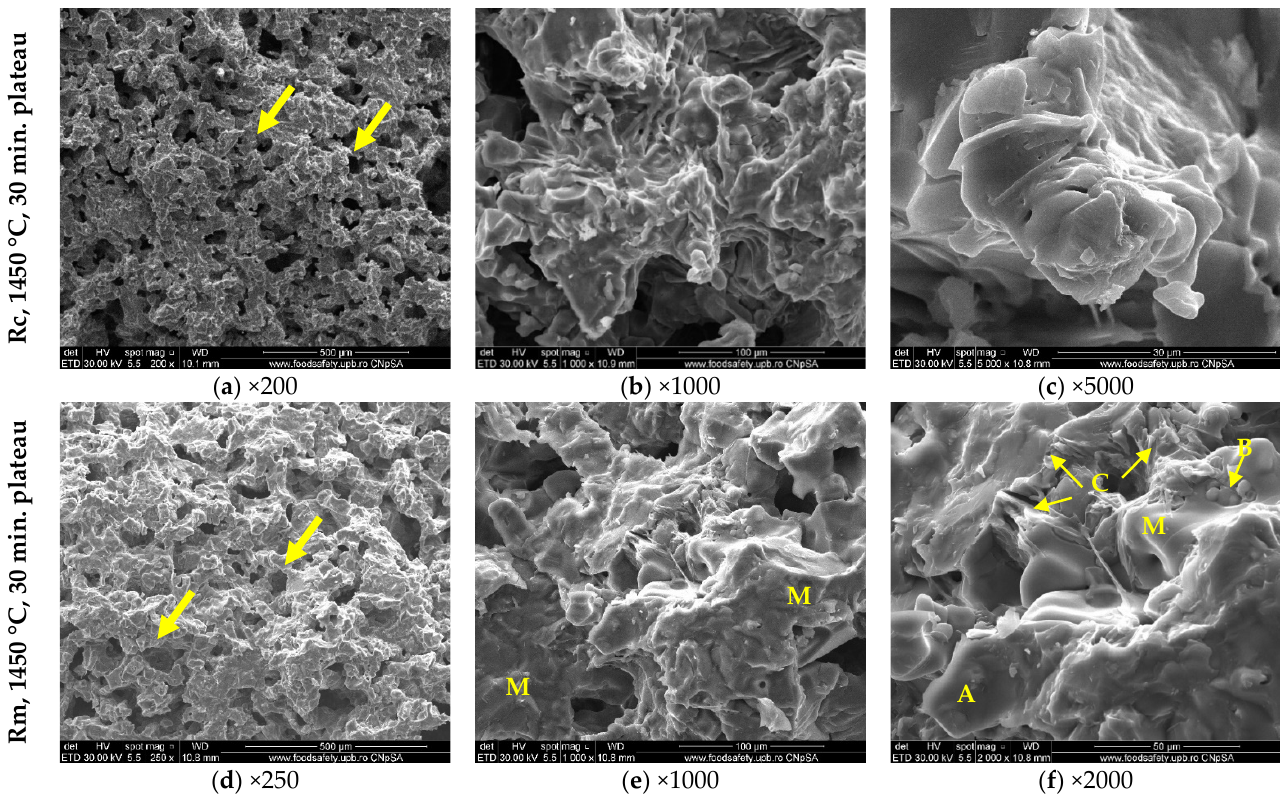
Figure 6. SEM images of Rc and Rm clinkers at different magnifications; A—alite; B—belite; C—calcium ferrite aluminate; M—melt; pores are indicated by arrows